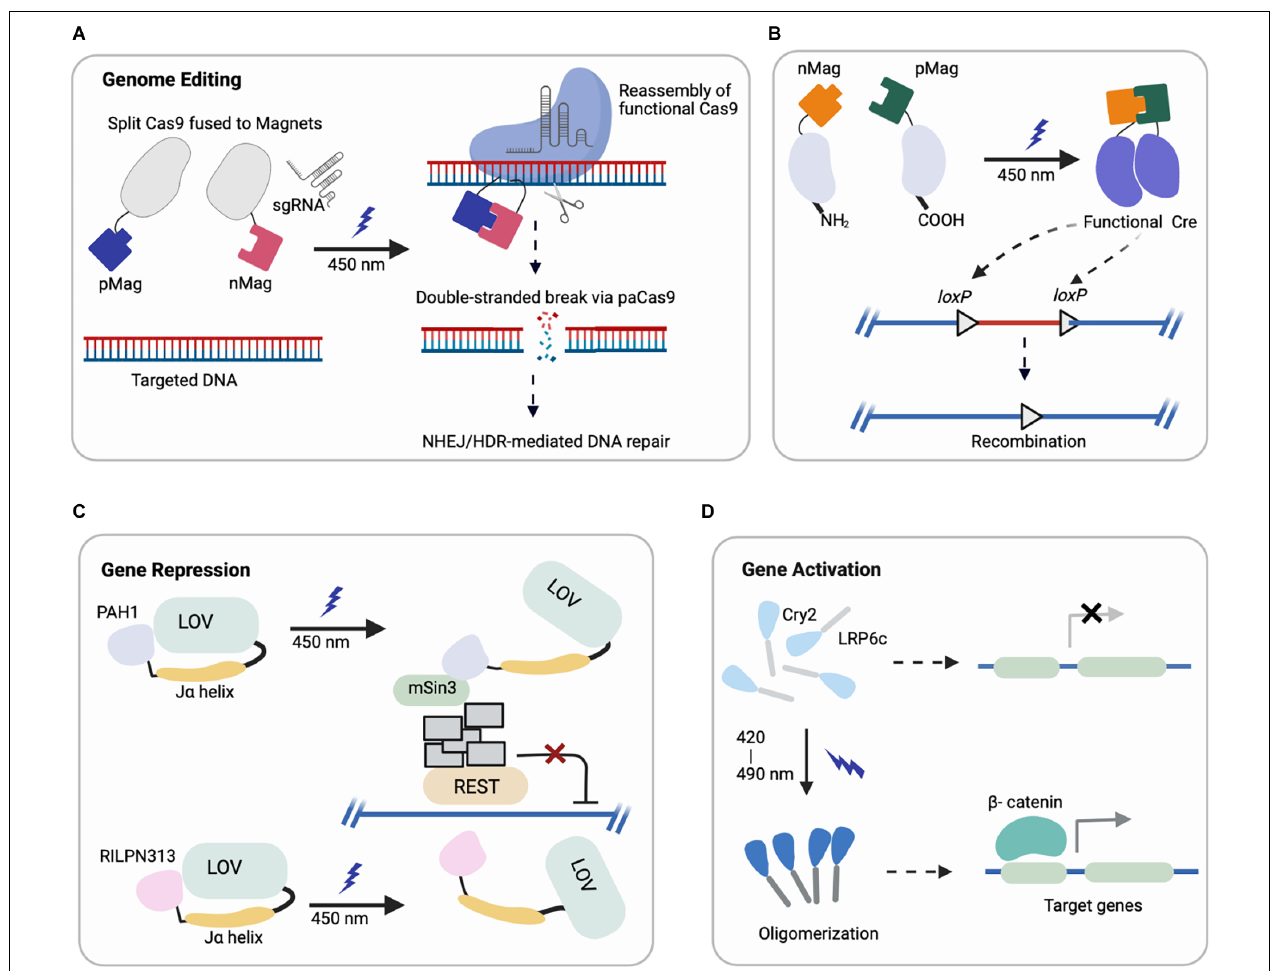
FIGURE 1 | Representative schematics of four major optogenetic-based gene regulations using different systems (created with Biorender ). (A,B) Light-induced uncaging of affinity domains (positive pMag) and (negative nMag) results in dimerization of attached domains and reassembly of (A) functional Cas9 for indel mutation and (B) split Cre recombinase for DNA recombination. (C) Upon light-induction, the J α helix unfolds from LOV2 core to uncage a fused protein (PAH1, RILPN313) that inhibits the binding and activity of targeted transcription factor (REST). (D) Cry2 clusters an attached protein (LRP6c) in response to light that activates the downstream target genes, e.g., Wnt